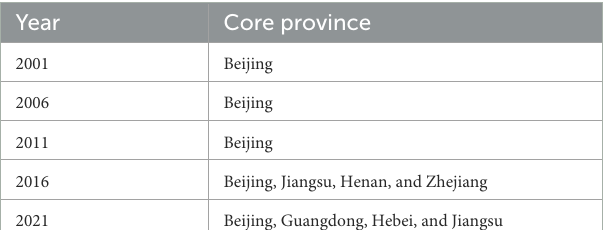
TABLE 8 Core provinces in China’s low-carbon patent cooperation network each year.